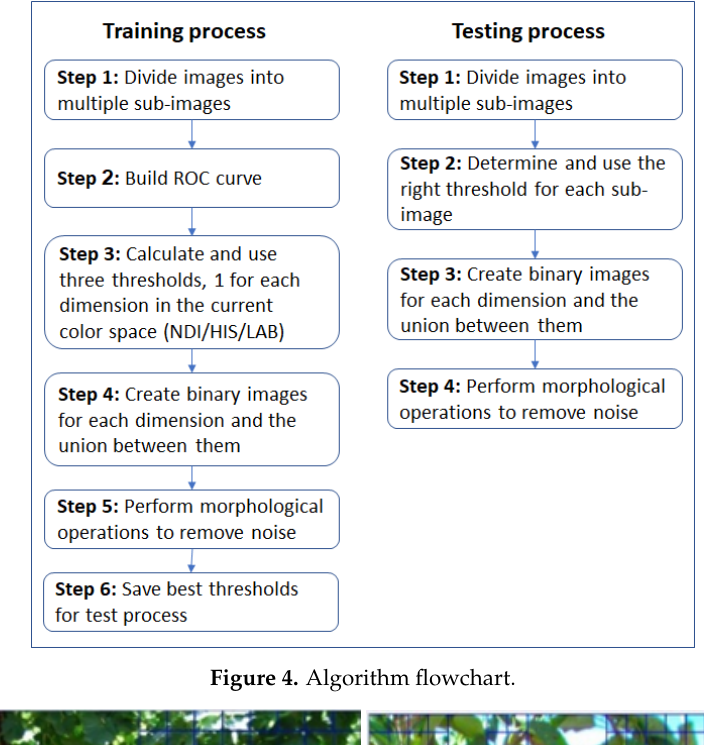
Figure 4. Algorithm flowchart.